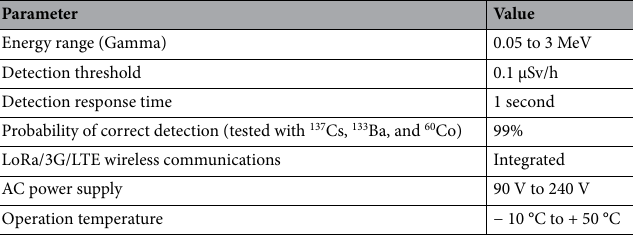
Table 2. Specifications of the fixed radiation device.